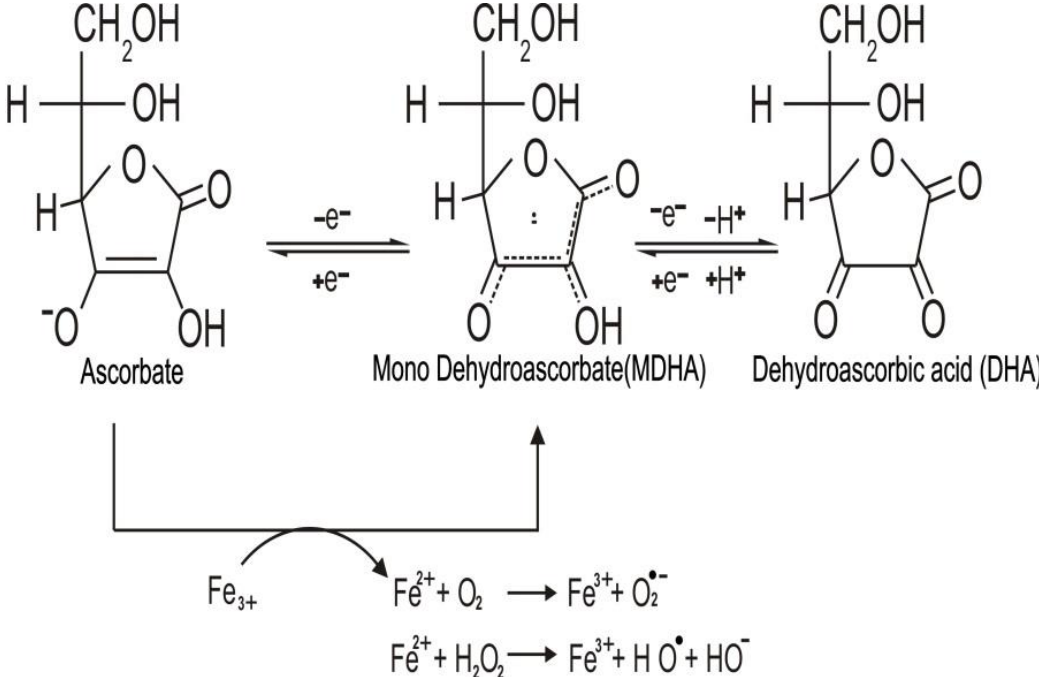
Figure 1. The three redox states of vitamin C (ascorbate, fully reduced form; mono dehydroascorbate, (MDHA), mono-oxidized form; dehydroascorbic acid (DHA), fully oxidized form). Ascorbate can donate one or two electrons to radicals and oxidant agents, forming MDHA and DHA, thus acting as a reducing agent. In the presence of metal ions such as iron, ascorbate can also reduce them and exert pro oxidant effects leading to formation of the superoxide radical (O 2•− ), hydrogen peroxide (H 2 O 2 ), and hydroxyl radicals (HO • ).